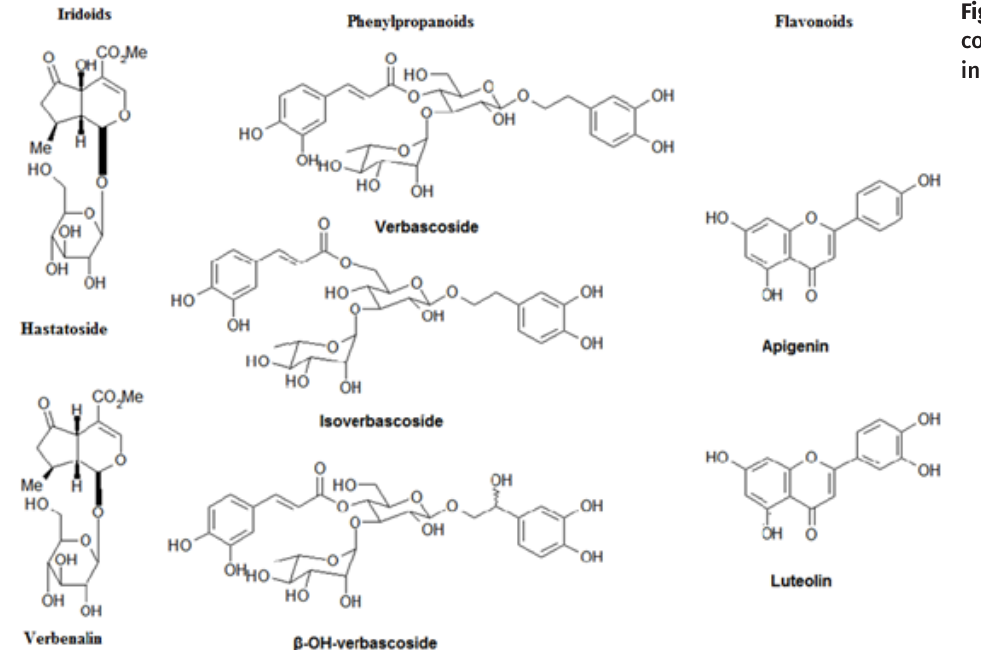
Figure 1. Main compounds found in Verbena